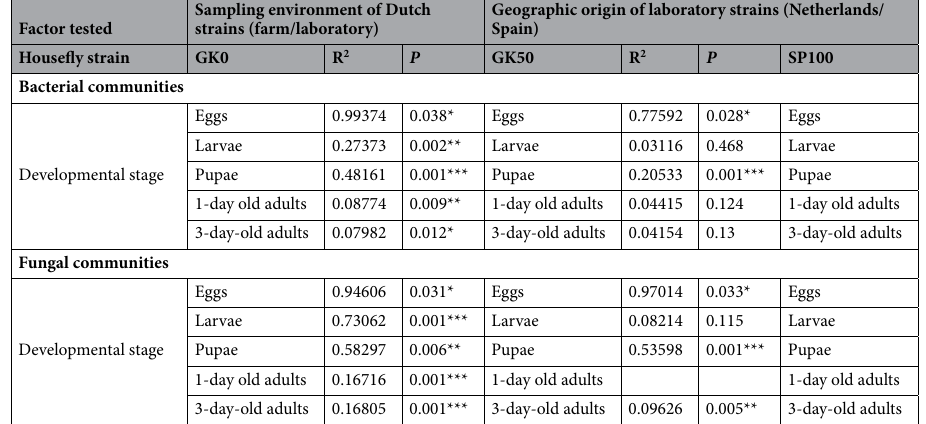
Table 1. Permutational multivariate analysis of variance for bacterial and fungal communities associated with each housefly developmental stage, based on weighted UniFrac distance matrices. Beta-diversity comparisons are conducted between the wild and laboratory Dutch strains, and between the Dutch and Spanish laboratory strains.